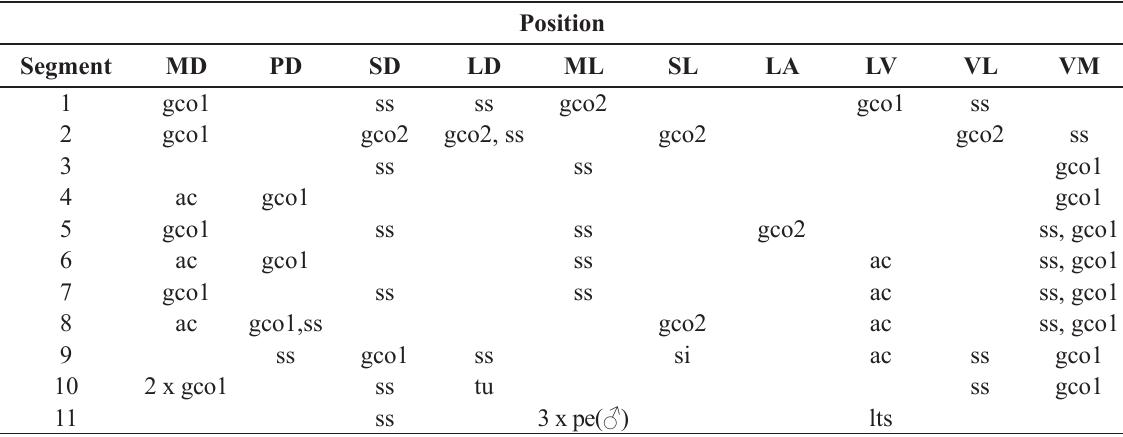
Table 3. Summary of nature and location of sensory spots, glandular cell outlets, tubes and spines arranged by series in Echinoderes anniae sp. nov. Abbreviations: LA = lateral accessory; LD = laterodorsal; LV = lateroventral; MD = middorsal; ML = midlateral; PD = paradorsal; SD = subdorsal; SL = sublateral; VL = ventrolateral; VM = ventromedial; ac = acicular spine; gco1/2 = glandular cell outlet type 1/2; lts = lateral terminal spine; pe = penile spines; si = sieve plate; ss = sensory spot; tu = tube; ( ♂ ) = putative male condition of sexually dimorphic